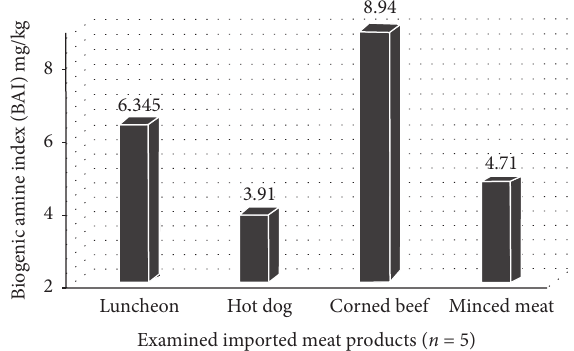
Figure 3: Biogenic amines index (BAI) (mg/kg) in examined imported meat products, good quality (BAI < 5 mg/kg, acceptable (BAI 5–20mg/kg), poor quality (BAI 20–50 mg/kg), and spoiled (BAI >